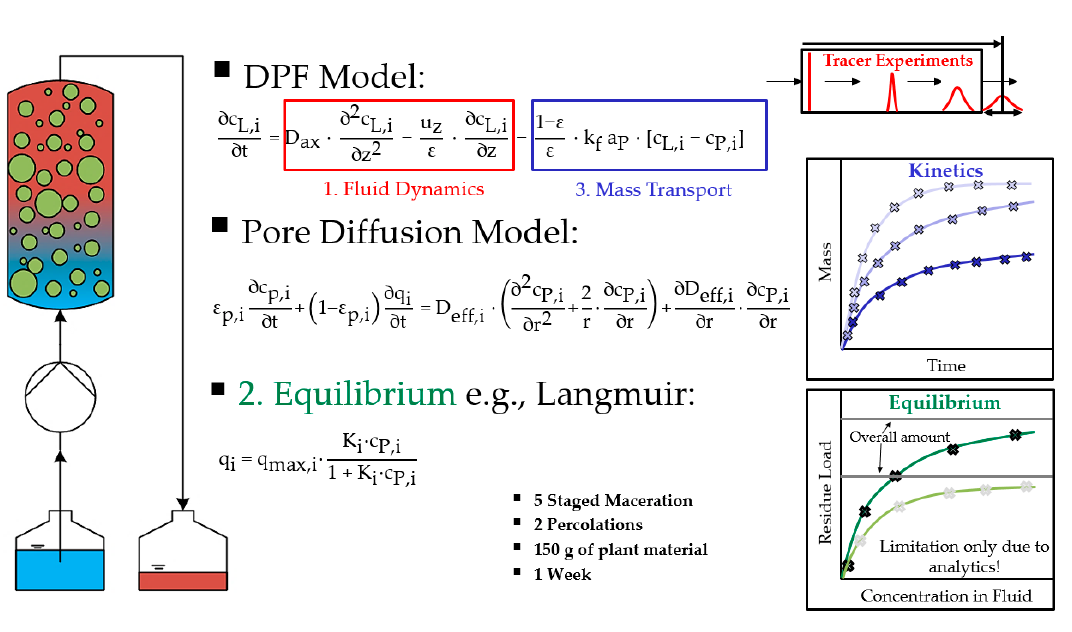
Figure 2. Model approach for solid-liquid extraction [15].